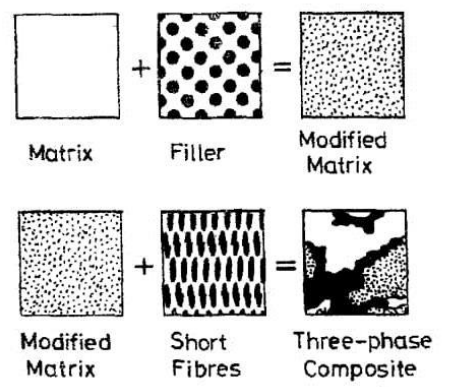
Figure 2. The three-phase model of composite with recycled particles [4].